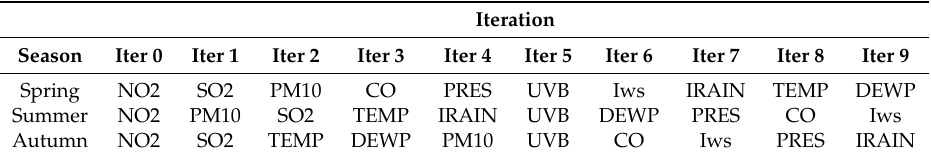
Table 1. The selection of model covariates according to AIC.